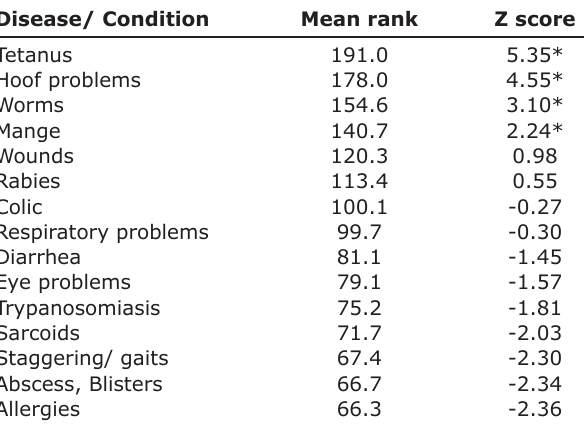
Table-3: Identified disease conditions affecting donkeys according to smallholder farmers in Kirinyaga County from June to September